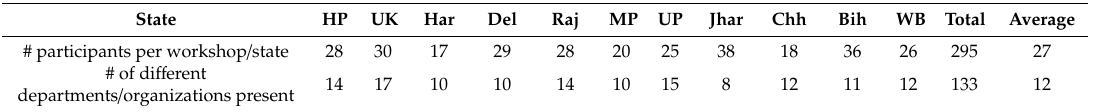
Table 5. Participation of stakeholder organizations in state-level model validation workshops, April–June